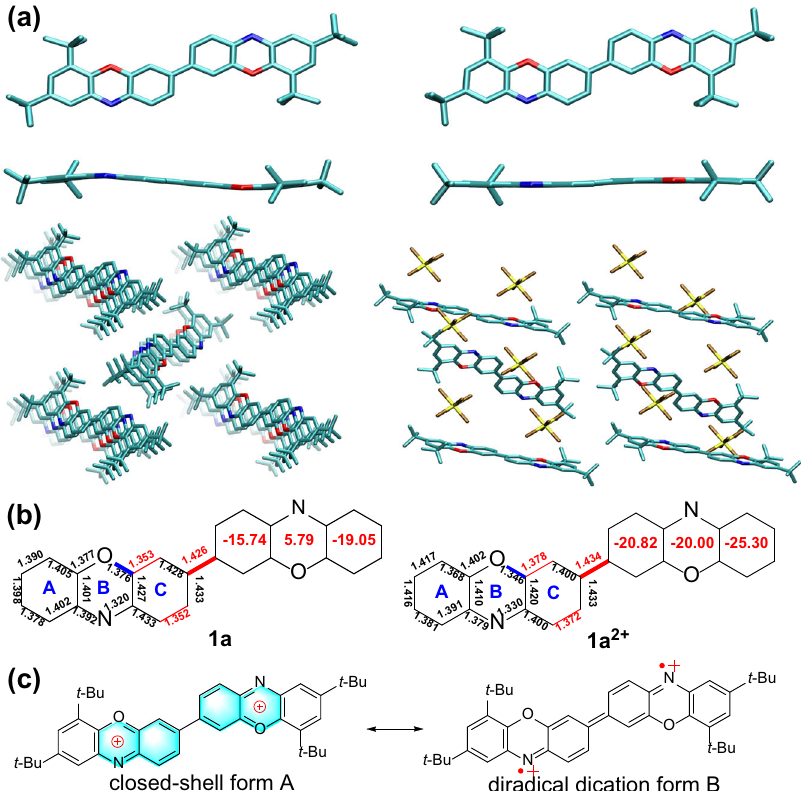
Fig. 4 Single crystal structures of 1a and 1a 2 + . Single crystal structures including top view, side view and packing modes ( a ), selected bond lengths ( b ) of 1a and 1a 2 + , and resonance structures of 1a 2 + ( c ). The red numbers in the rings denote the calculated NICS(1) ZZ